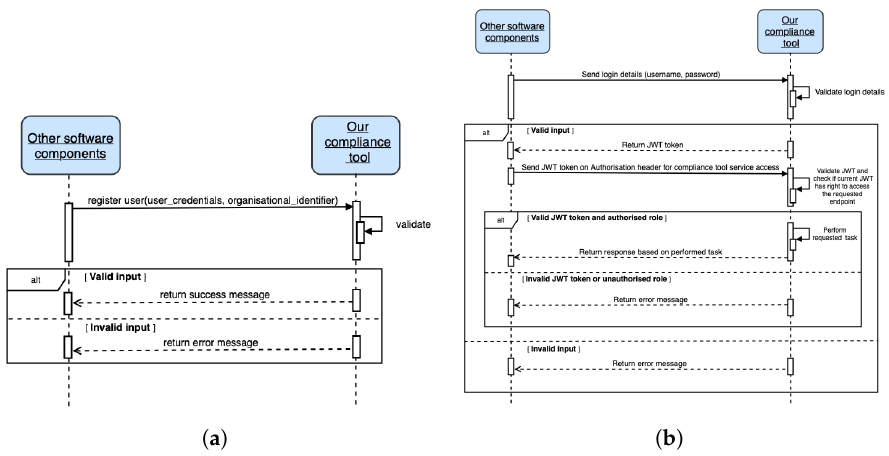
Figure 6. A snapshot of the REST API’s endpoints in Swagger.